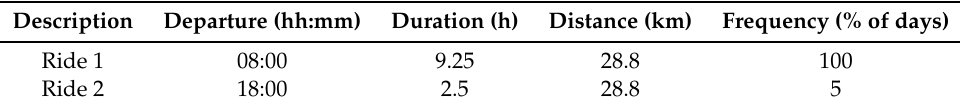
Table A1. Primary EV schedule for a working-day.